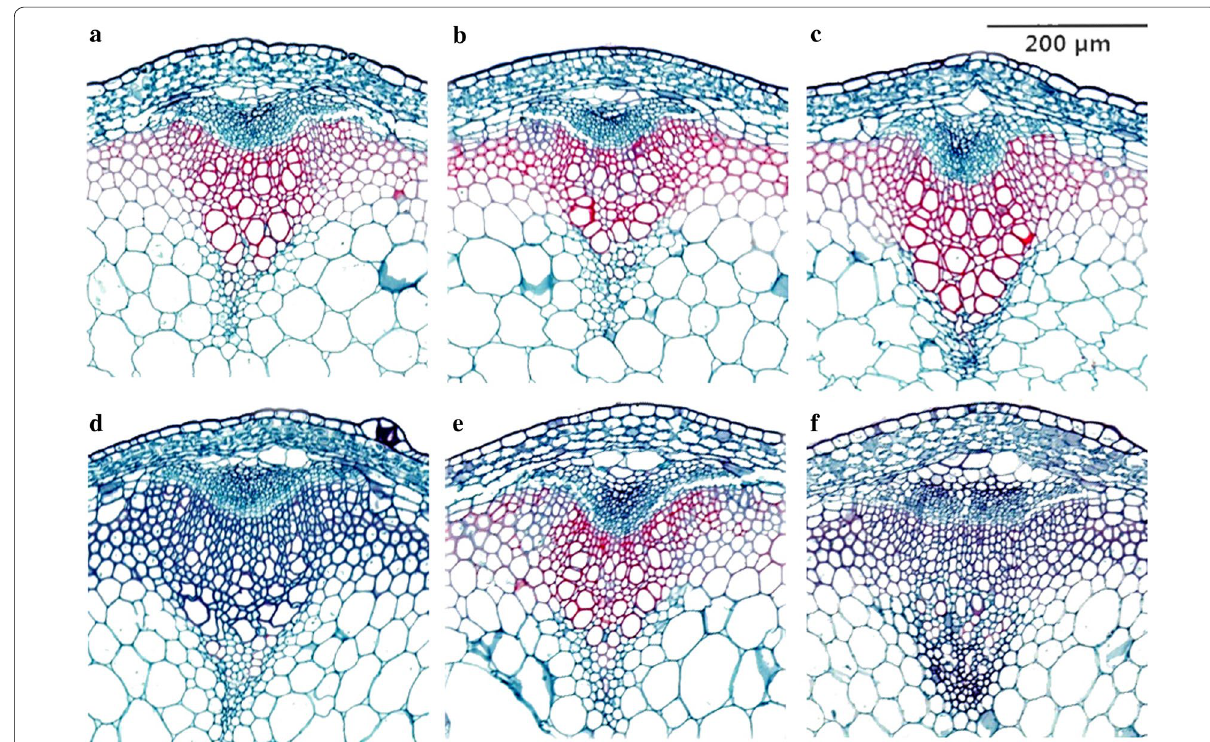
Fig. 4 Paraffin sections of stems of representative lines stained with safranin and fast green. a WT; b WT - 35S:NcCSE ; c WT - 35S:NcHCT ; d cse ; e cse - 35S:NcCSE ; f c se - 35S:NcHCT ; bar 200HCT =